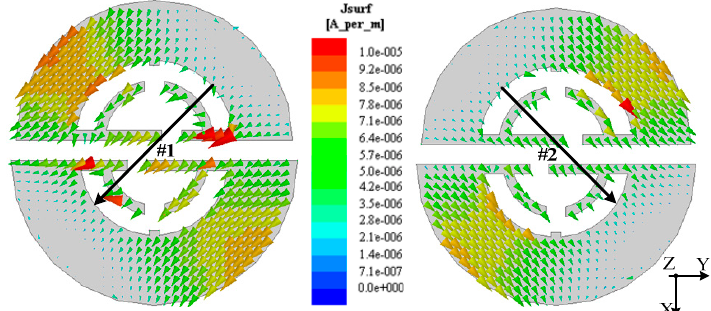
Figure 3. Surface current distribution on the DSSRs of the polarizer at its modes #1 and #2, corresponding eigenfrequencies f #1 = 2.5189 GHz and f #2 = 2.5190 GHz, respectively, in terms of the eigenmode model.